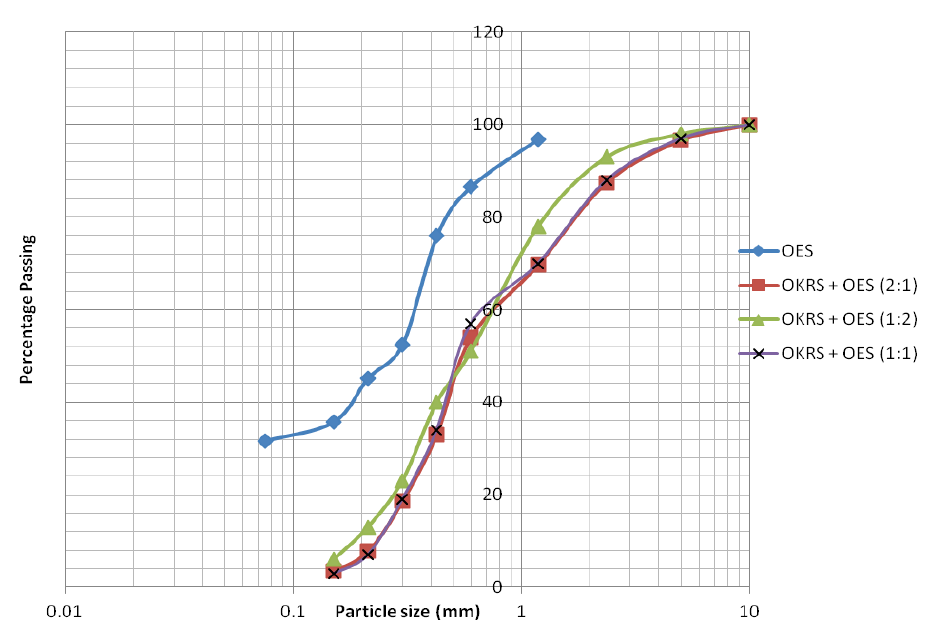
Figure 5. Grading curves for OES and its various combinations with